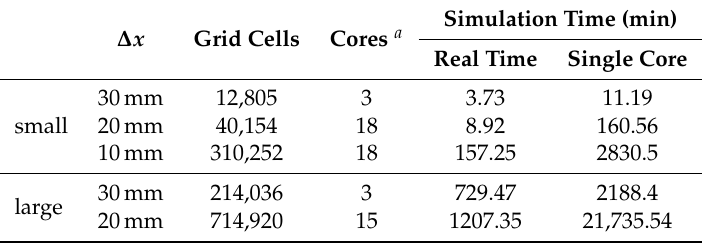
Table 3. Computational costs depending on grid size in the small and large tank scenarios. ∆ x Grid Cells Cores